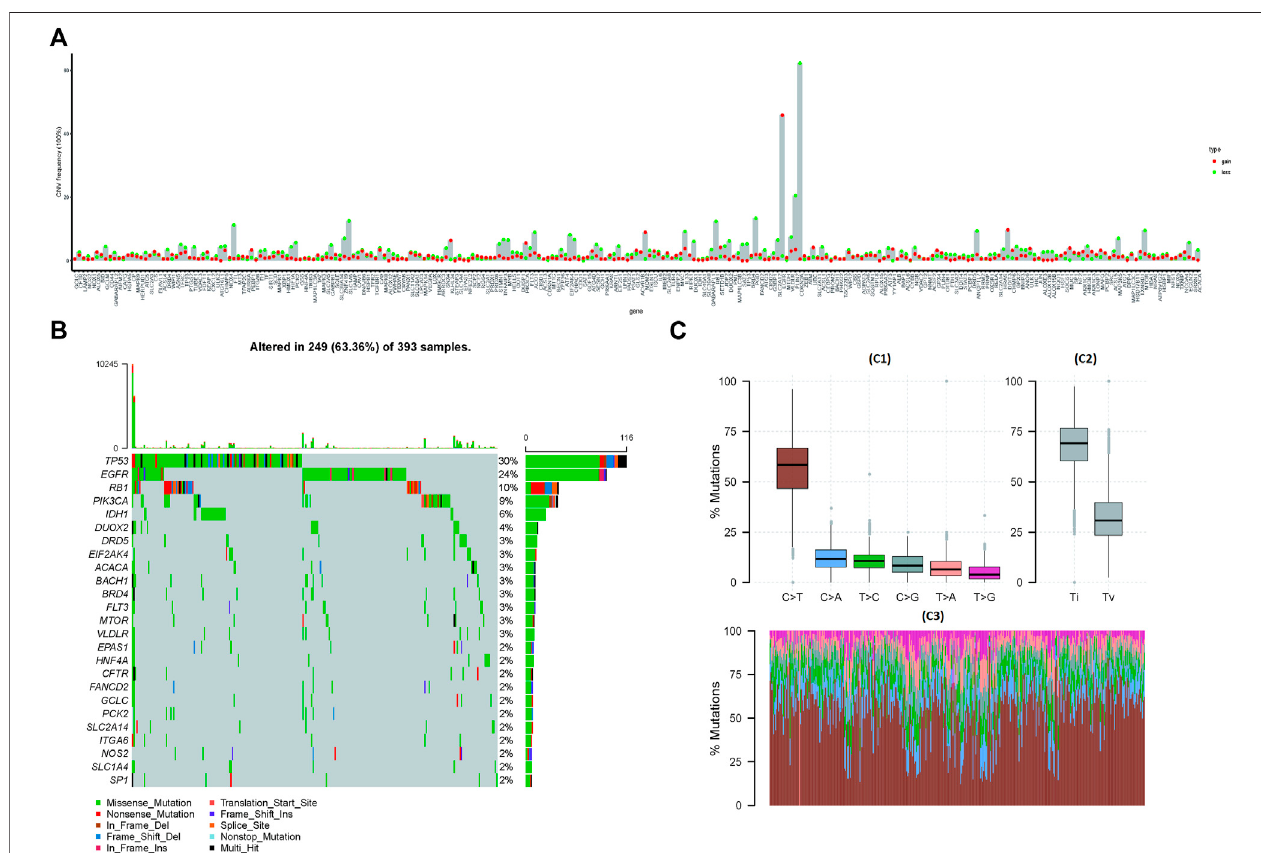
FIGURE 1 | Mutations and copy number variations (CNVs) in ferroptosis-related genes. (A) CNV of ferroptosis-related genes. The abscissa axis represents the nameoftherelatedgenes;theordinateaxisrepresentstheCNVfrequency.ThetypeofCNVrepresentedbyredisgain;thetypeofCNVrepresentedbygreenisloss. (B) Waterfallchartofferroptosis-relatedgenemutations.Theordinateaxisontheleftrepresentsthenamesofthetop25genes,andtheordinateaxisontherightrepresents the mutation frequency of the corresponding genes; different colors represent different types of gene alterations. (C) SNP of TCGA-GBM samples (C1): the abscissa axis represents the type of SNP; the ordinate axis represents the mutation percentage. (C2): the abscissa axis represents the type of variants (transitions or transversions);theordinate axisrepresentsthepercentage ofmutations.(C3):theabscissaaxis representstheTCGA-GBMsamples, inwhichdifferentcolorsrepresent different SVP types, and the ordinate axis represents the percentage of variation in each